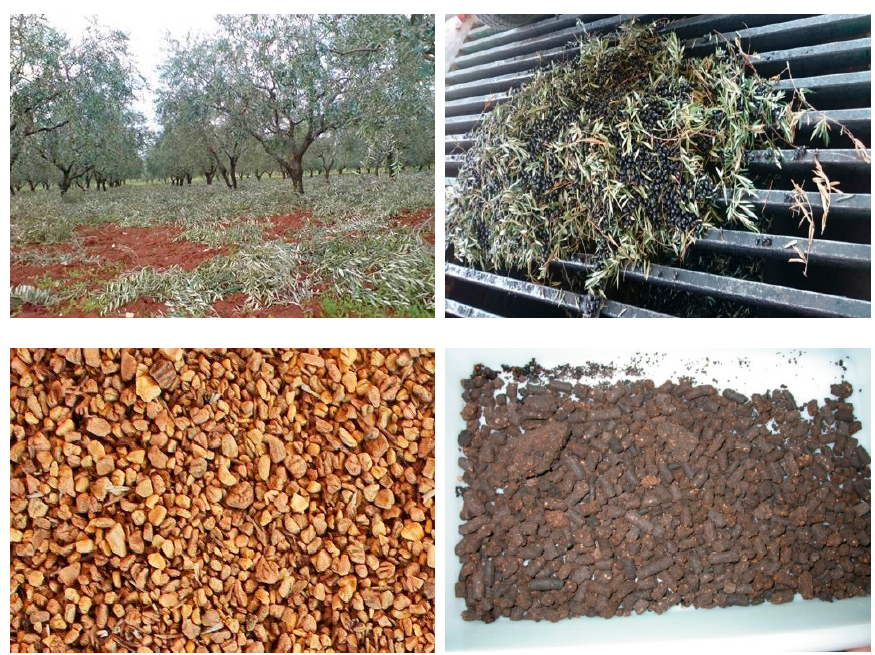
Figure 1. Olive by-products: olive tree pruning (top-left), olive leaves (top-right), olive stones (bottom-left) and extracted olive pomace (bottom-right).